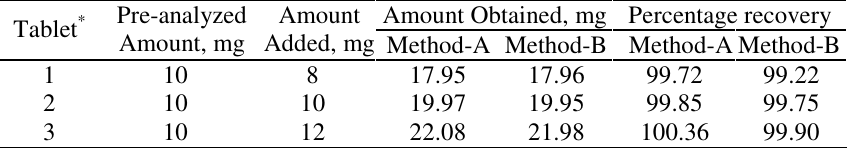
Table 3. Recovery